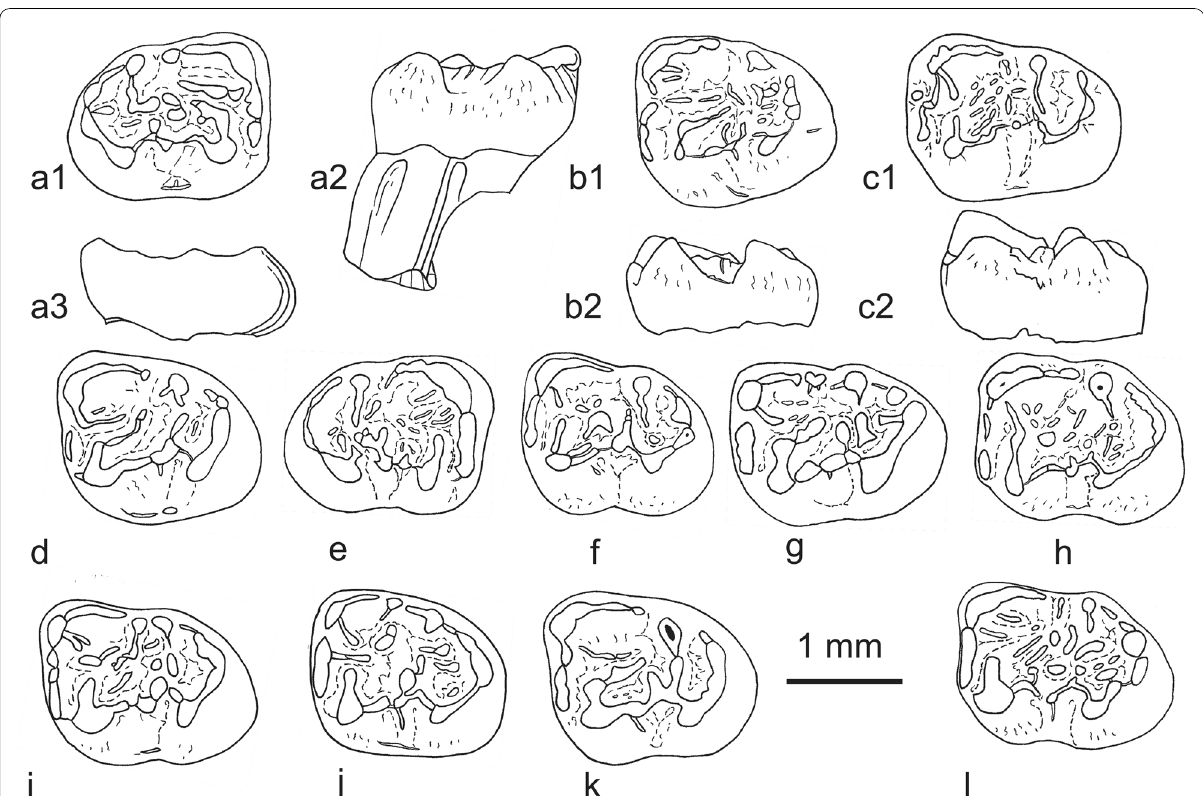
Fig. 37 Lower m3 of ? Protadelomys alsaticus Hartenberger, 1969 from Bouxwiller (Bas‑Rhin). a BUX67‑14, right m3; a1, occlusal view; a2, buccal aspect; a3, lingual aspect. b BUX67‑153, left m3; b1, occlusal view; b2, buccal aspect. c : BUX67‑164, left m3; c1, occlusal view; c2, buccal aspect. d BUX67‑157, left m3, occlusal view. e BUX67‑158, right m3; occlusal view. f BUX67‑155, left m3; occlusal view. g BUX67‑160, left m3; occlusal view. h BUX67‑159, left m3; occlusal view. i BUX67‑29, left m3; occlusal view. j : BUX67‑151, left m3; occlusal view. k : BUX67‑152, left m3; occlusal view. l : BUX67‑168, left m3;, occlusal view. Scale bar 1 =